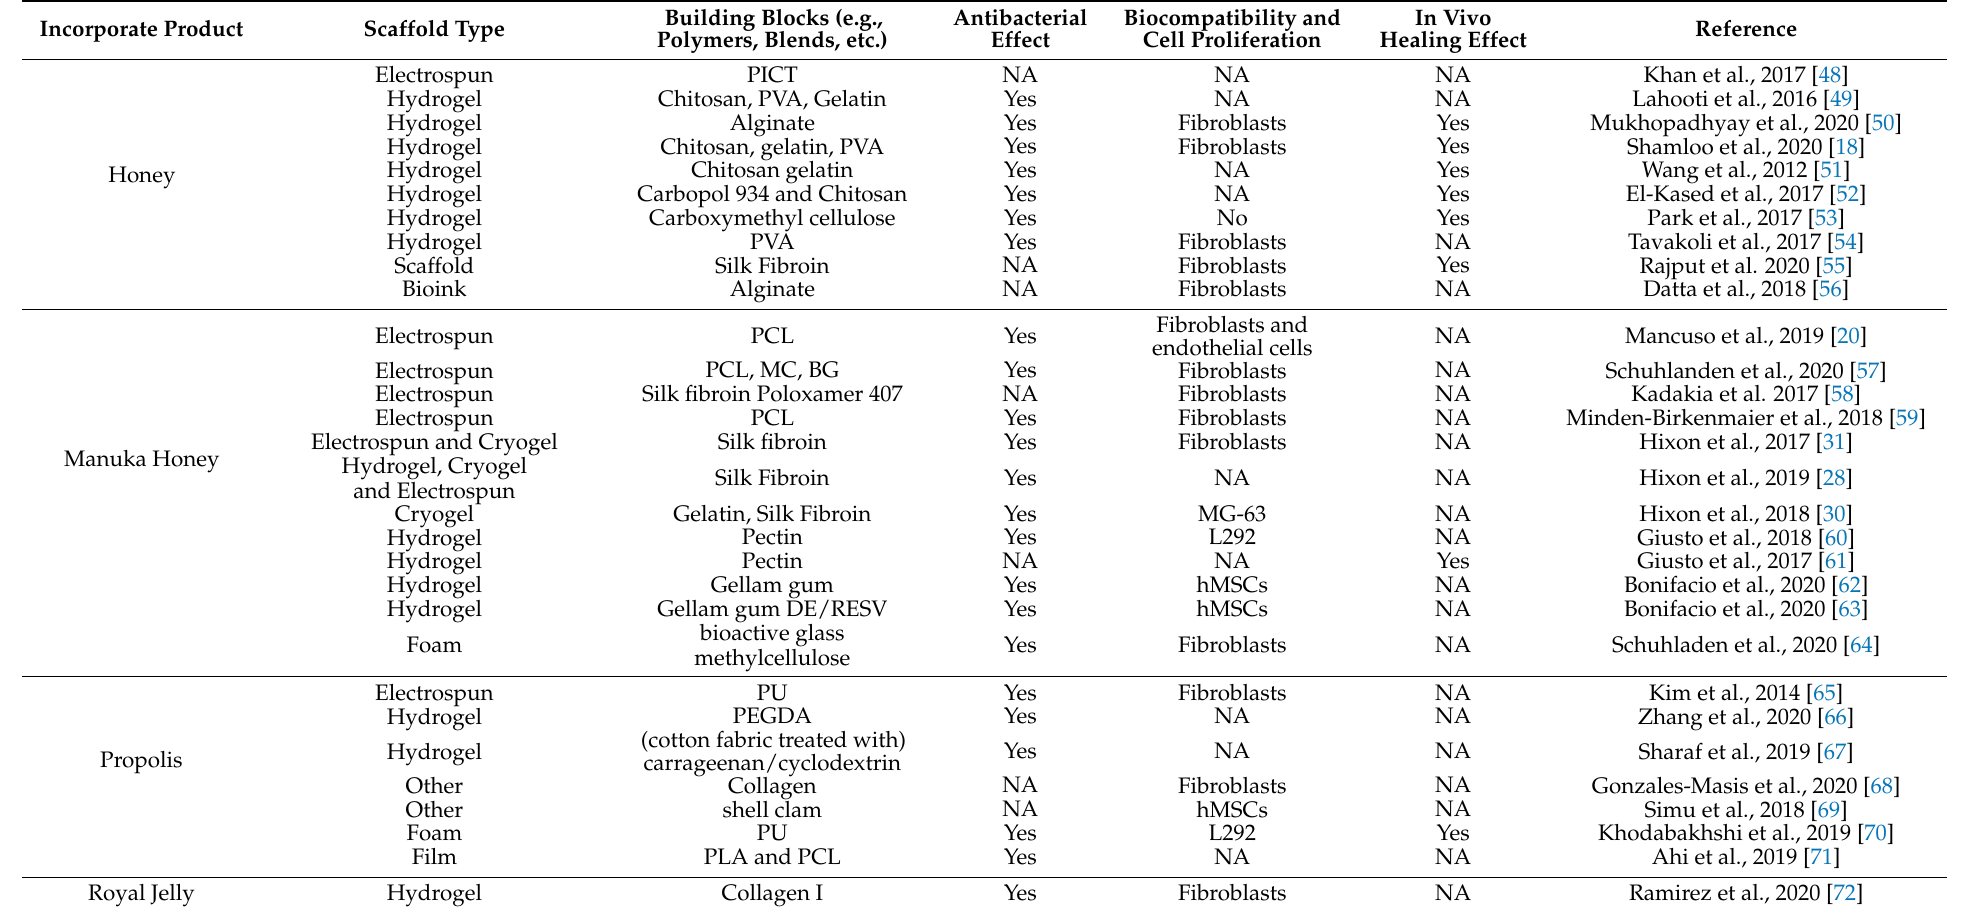
Table 1. Experimental studies on biomaterials functionalized with honeybee products analyzed in this